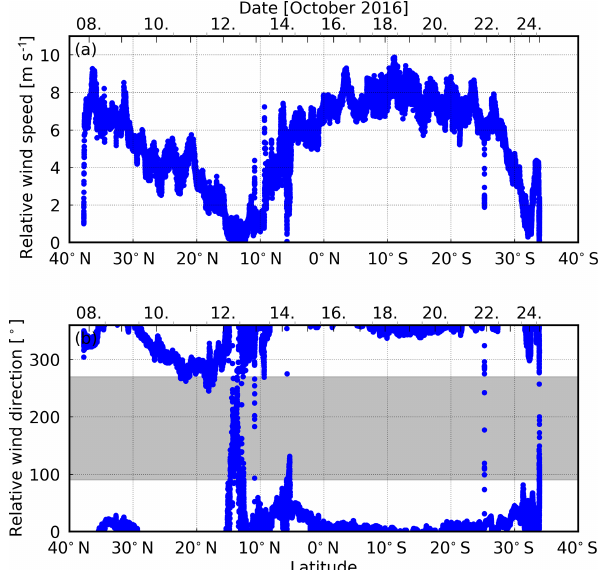
Figure 3. Relative (a) wind speed and (b) wind direction (0 ◦ in- dicates headwinds) during the COPMAR campaign. Grey shaded measurements are excluded from the analysis in order to avoid pos- sible contamination by the vessel’s